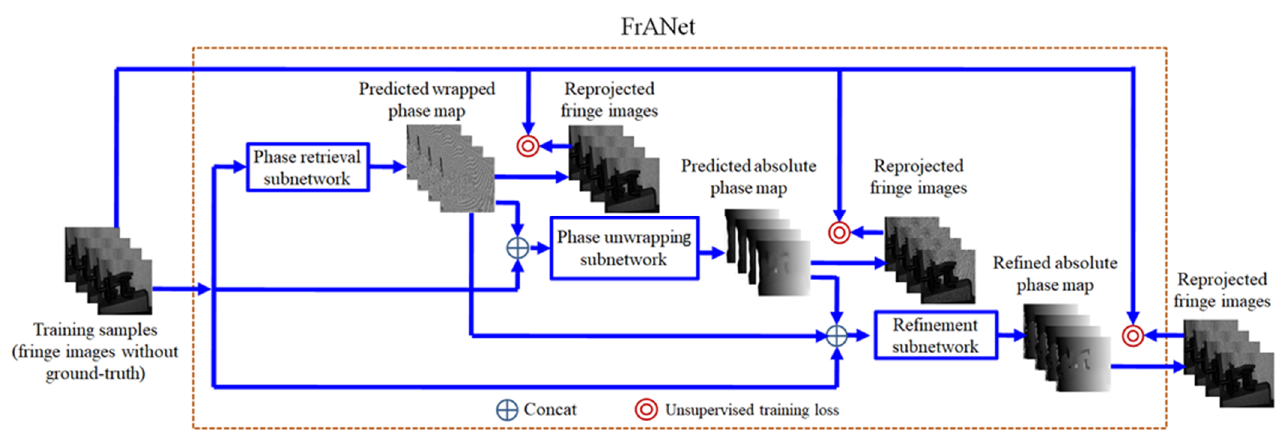
Figure 3. Overview of the unsupervised training process of the FrANet.